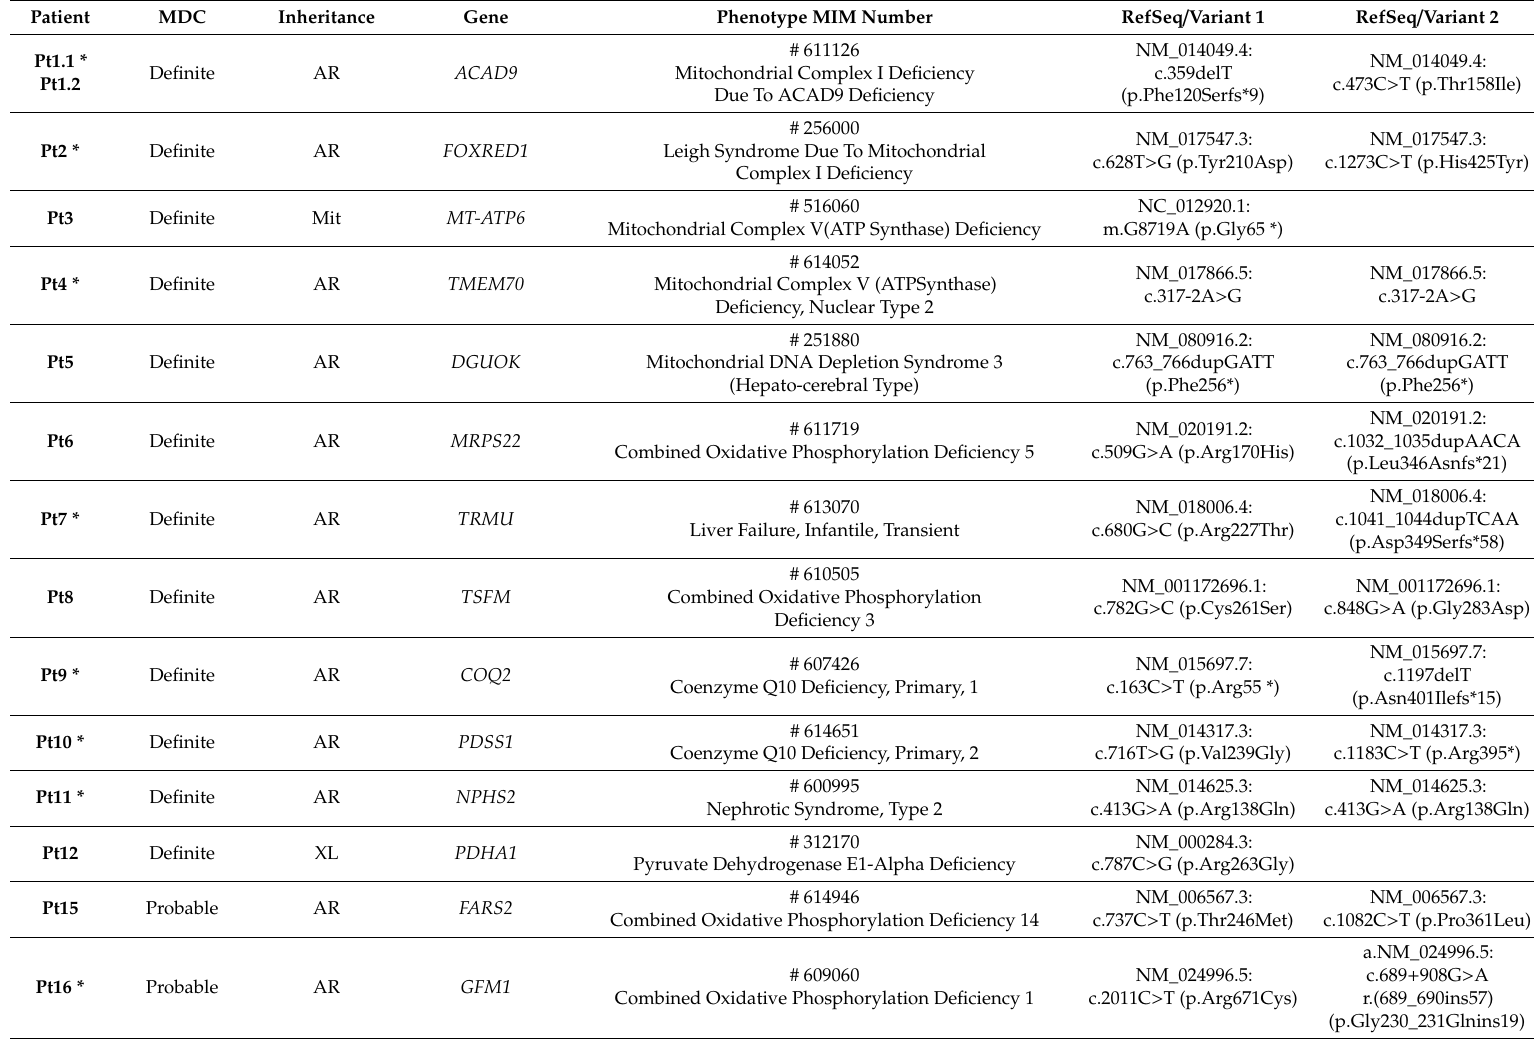
Table 1. Genes and